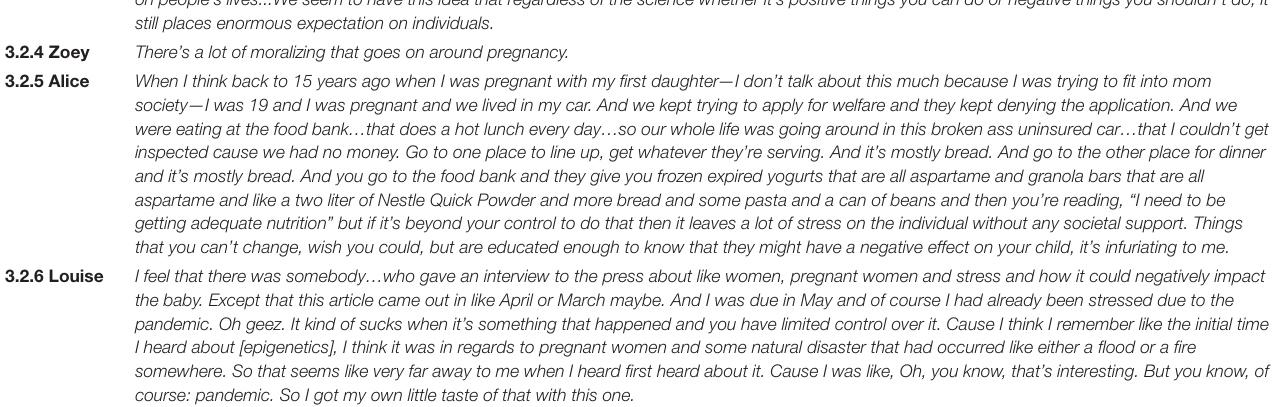
narratives revealed that consumption of knowledge